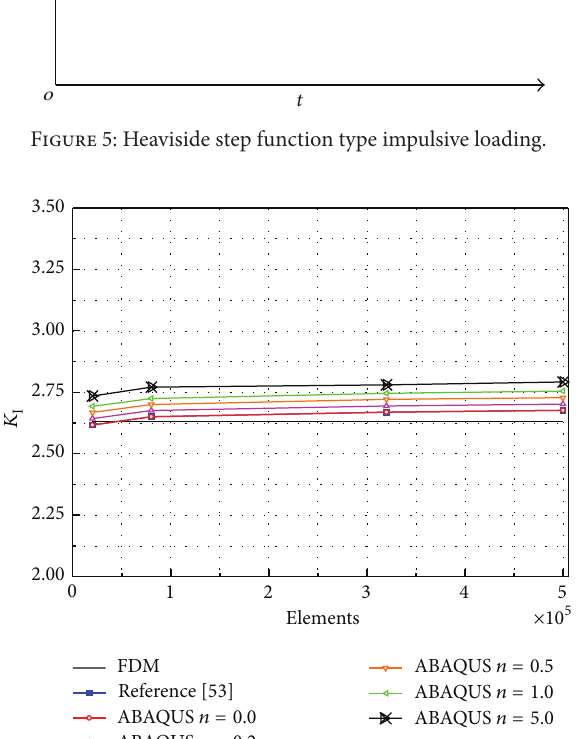
Figure 6: The convergence of the normalized DSIFs 𝐾 I at 𝑡 = 7 𝜇